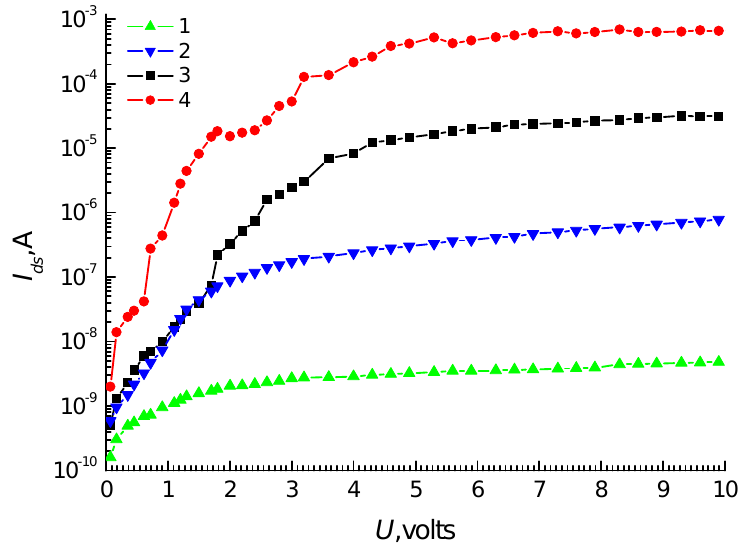
on bias U before (curve 1) and after adsorbing Figure 4. Dependences of current I ds TORSV and GFLV viruses, and protein particles (curves 2 to